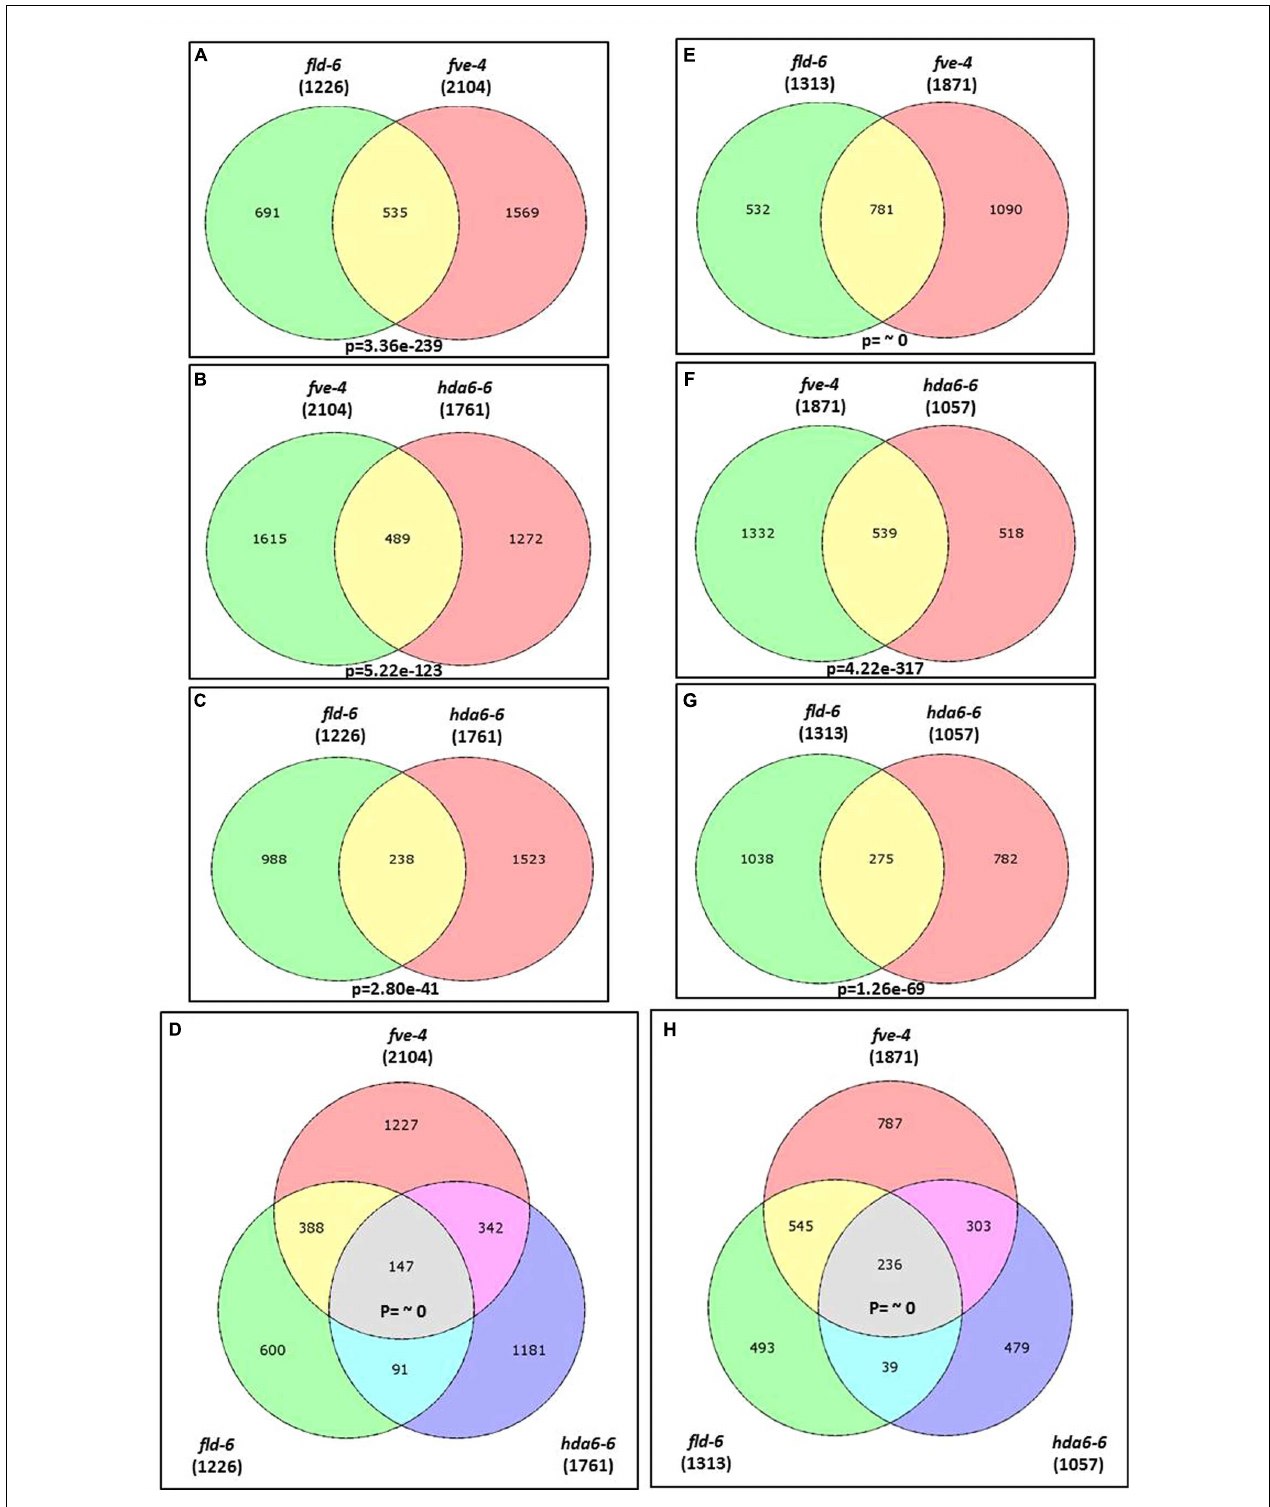
FIGURE 4 | Transcriptome profiles of fve-4 , fld-6 and hda6-6 mutants. (A–D) Venn diagrams showing the number of genes up-regulated ( > twofold, p -value < 0.05) in fve-4 , fld-6, and hda6-6 mutants by using RNA-sequencing analysis. (E–H) . The number of genes down-regulated ( < twofold, p -value < 0.05) in fve-4 , fld-6, and hda6-6 mutants. Numbers in parentheses represent the total numbers of up- or down-regulated genes in the respective mutants. The P -value of the Venn diagram (A–C and E–G) was calculated using the hypergeometric distribution. (D,H) Simulation-based P -values were calculated via R project.